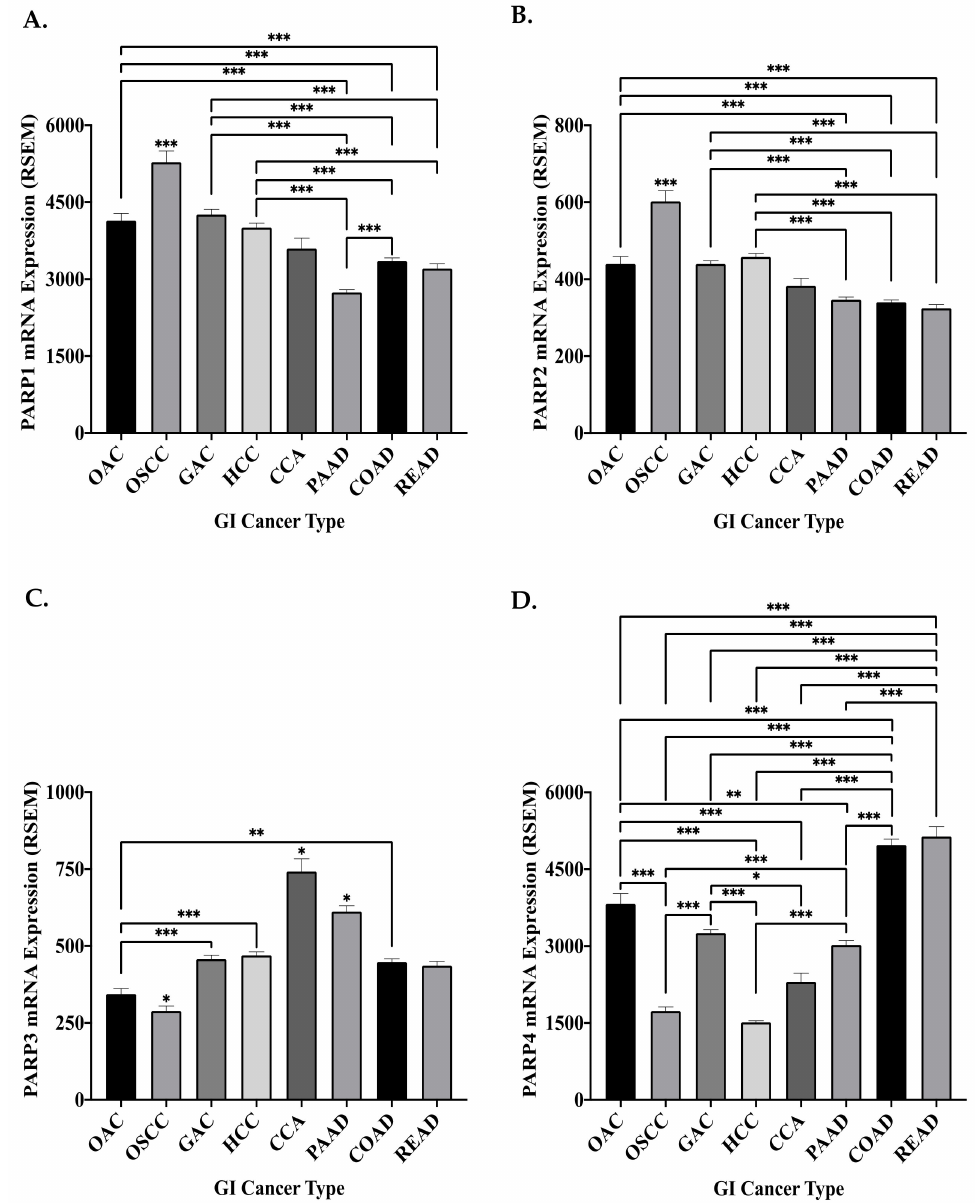
Figure 3. Mean mRNA expression of the DNA damage response PARP genes in GI cancers. The mean mRNA expression of ( A ) PARP1 ( B ) PARP2 ( C ) PARP3 and ( D ) PARP4 in GI cancers. OAC, n = 97; OSCC, n = 94; GAC, n = 412; HCC n = 363; CCA, n = 36; PAAD, n = 177; COAD, n = 377; READ, n = 154. Data are presented as the mean RSEM ± SEM. Statistical analysis was performed using one-way ANOVA with Tukey’s multiple comparison post-hoc test, * p ≤ 0.05, ** p ≤ 0.01, *** p ≤ 0.001. When significance is not directly comparing two groups, it is significant in comparison to all other